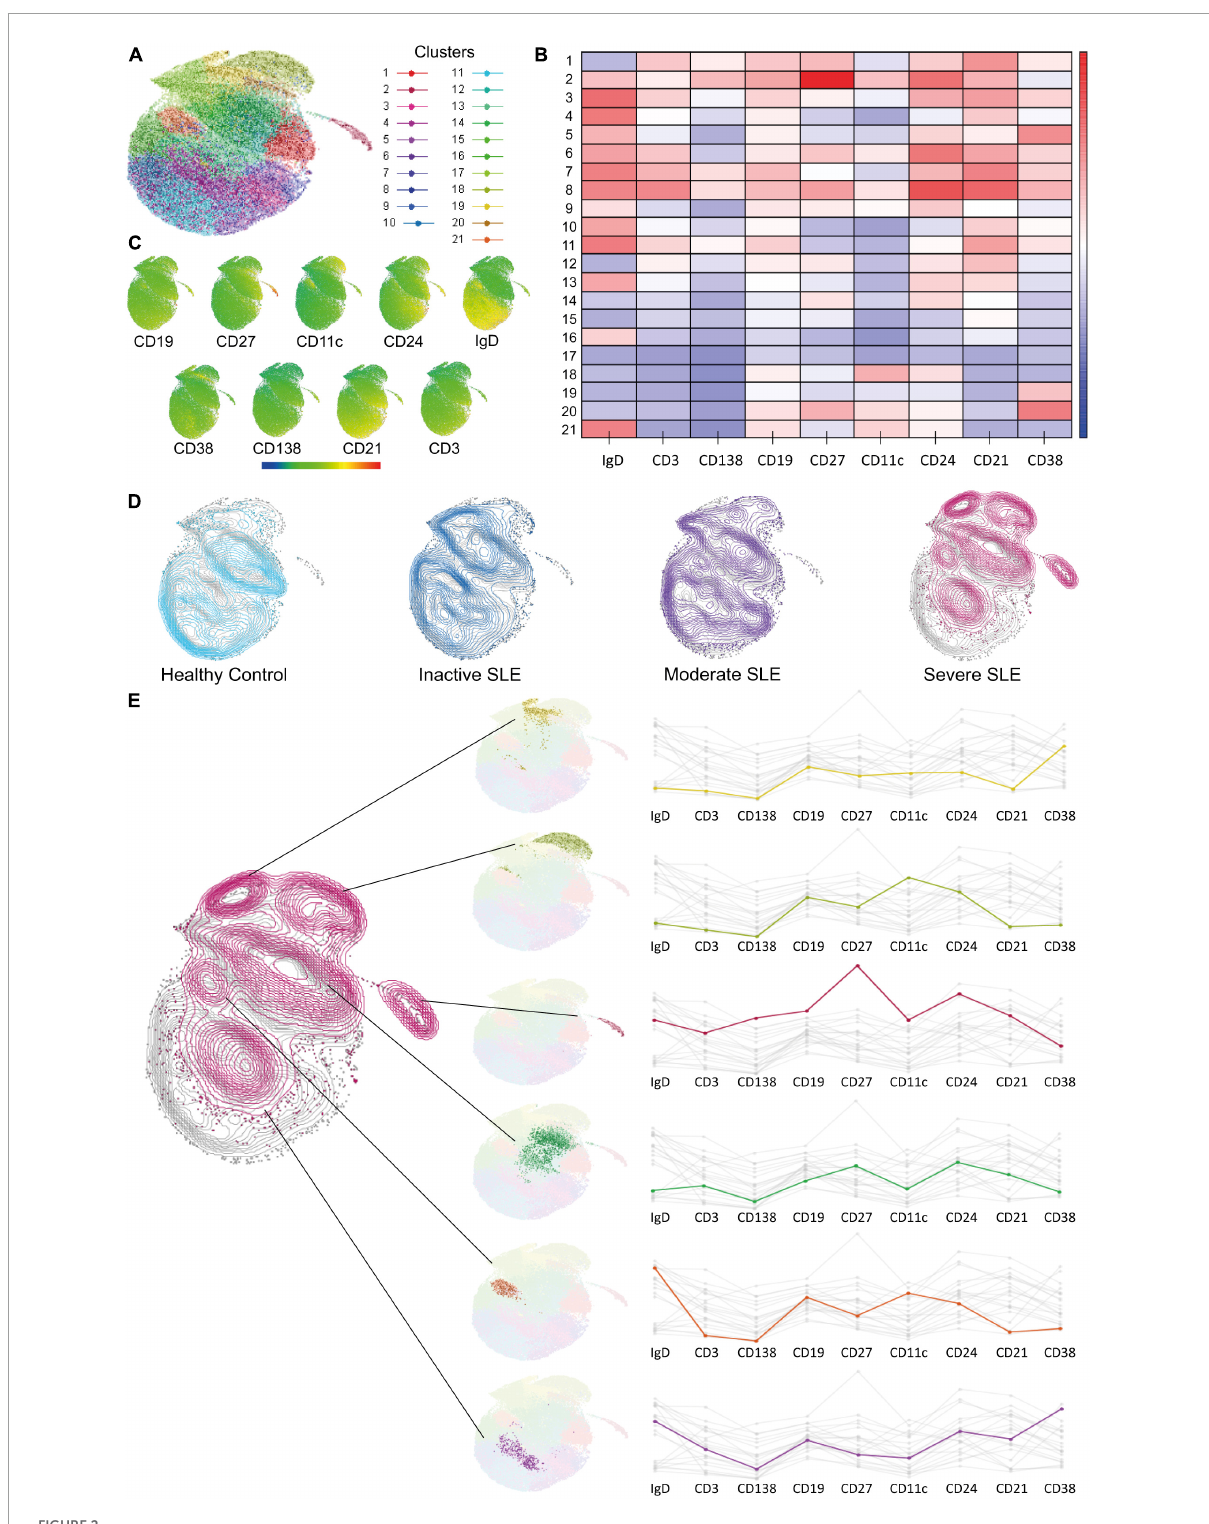
FIGURE2 Dimensionality reduction analysis to identify new B cell subsets. (A) UMAP analysis for dimensionality reduction and identified clusters. (B,C) Heat map showing marker’s expression levels for each cluster. (D) Comparison of cluster’s expression in Healthy Controls (clear blue), Inactive (dark blue), Moderate (purple), and Severe (dark pink) active SLE patients. (E) Clusters with a differential expression when comparing between HC and patients with severe active SLE patients and its